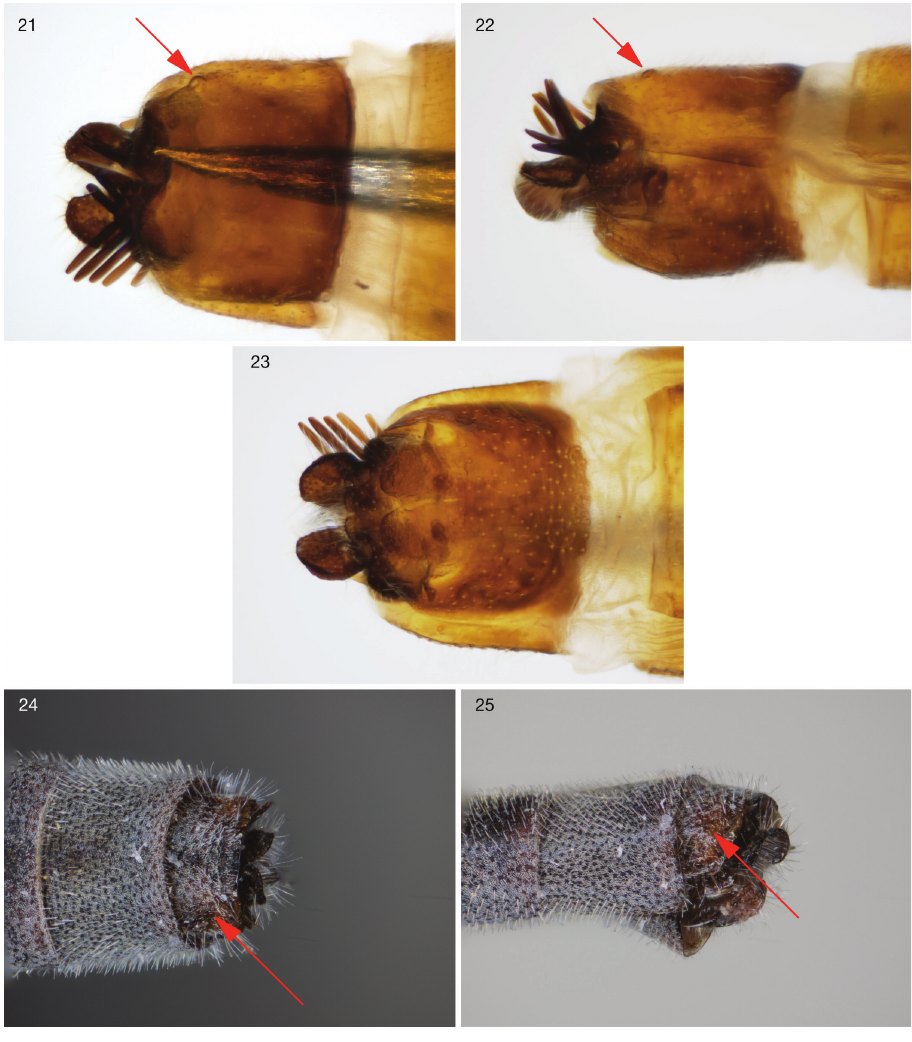
Figures 21–25. Microphontes gaiophanes sp. n. ♀ terminalia: 21 USNMENT01384130 (cleared), dorsal (Morphbank #861803) 22 same, lateral (#861805) 23 same, ventral (#861807) 24 USN- MENT01384008, dorsal (Morphbank #861809) 25 same, lateral (#861811). Arrows highlight postero- paramedian T8 pores. Magnification: Female (Figs 21–25): T6–8 grey pubescent, setation directed anteriorly on T6–7 and dorsally on T8; postero-paramedian T8 pores present, distinct, opening slightly el- evated above tergite surface; T8 without any internal apodeme anteriorly; T10 divided into 2 heavily sclerotised acanthophorite plates, with 8–9, dark brown acanthophorite spines per plate; 3 spermathecae, median spermatheca larger than lateral ones, reach- ing anterior end of segment 7; common spermathecal duct very long, extending well beyond tip of genital fork (S9, furca), individual spermathecal ducts short; spermathe- cal reservoirs formed by more or less expanded ducts to sac-shaped reservoir, heavily